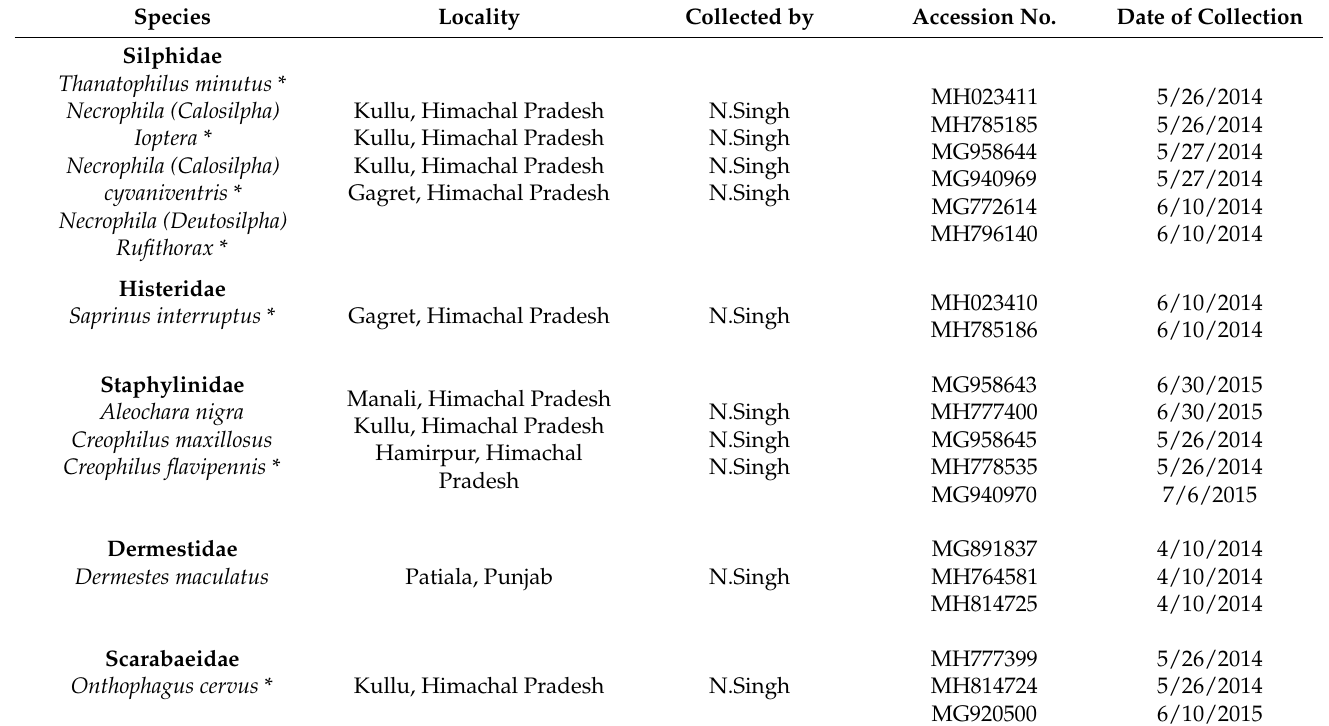
Table 1. Details of species included in this study, their locality and accession number. Locality Collected by Accession No.